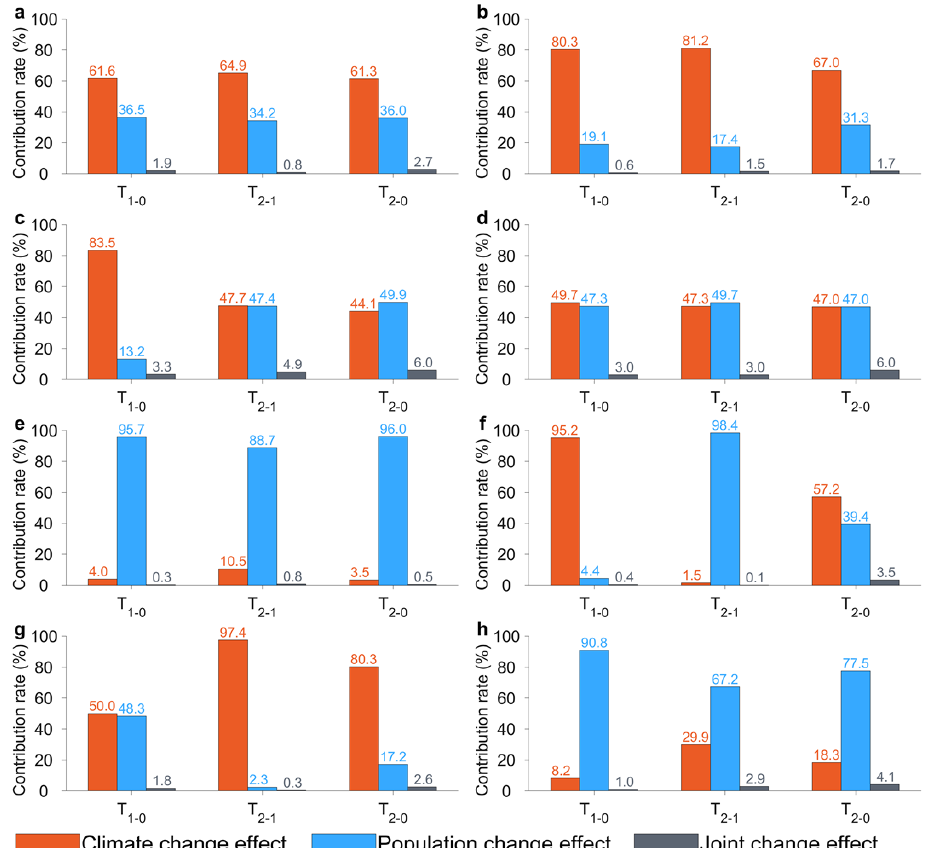
Figure 8. Breakdown of the changes in population exposure for tropical cyclone hazard scenario II in the Northwest Pacific. ( a – h ): Breakdown of the change in population exposure for regions A, B, C, D, E, F, G, and H, respectively.